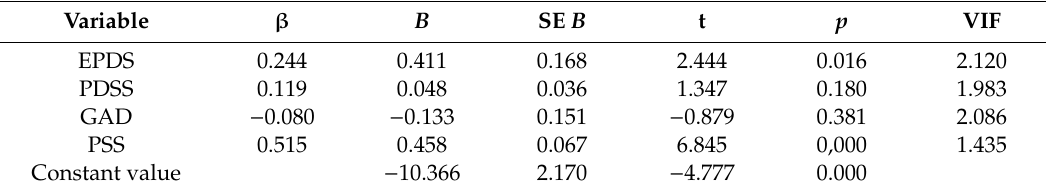
Table 5. Significance of the standardized regression coe ffi cients describing the relationship between PBQ scores and depressive symptoms, anxiety and stress. Variable β B SE B t p